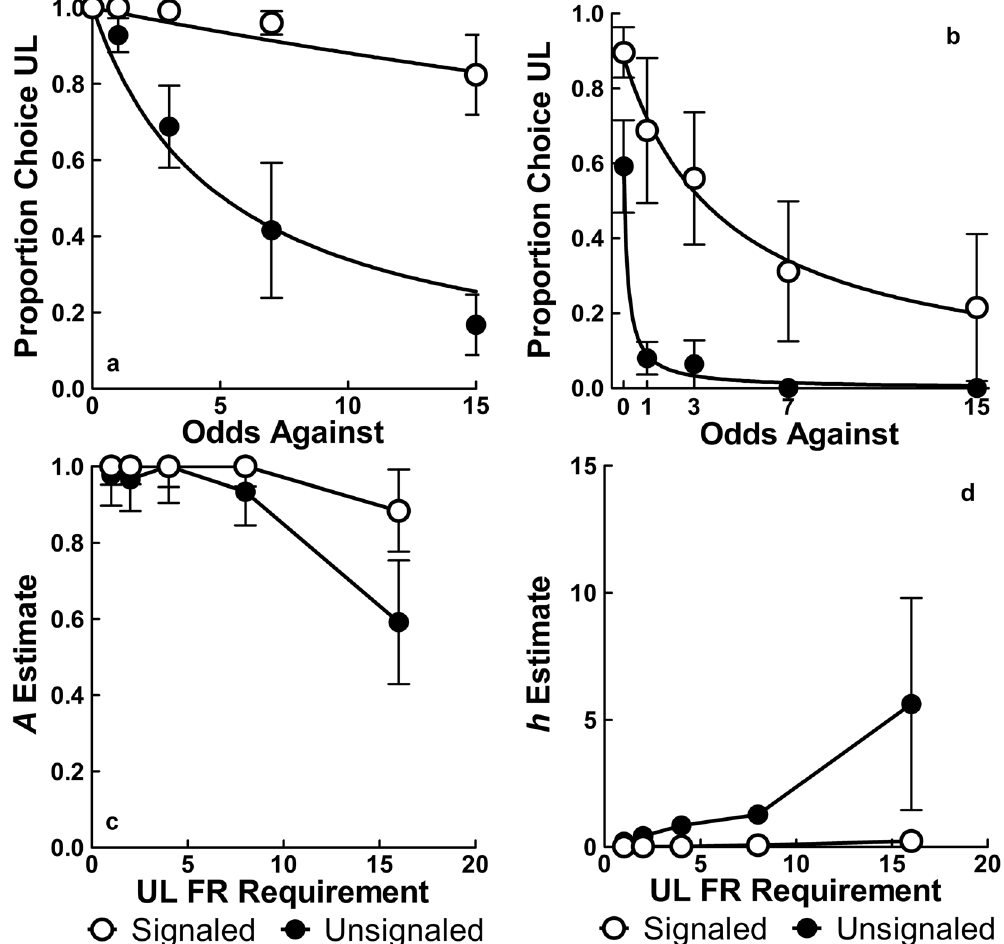
Figure 6. Top: mean ( ± SEM) proportion choice UL for the Signaled and Unsignaled groups at response costs of 1 ( a ) and 16 ( b ); additional costs can be seen in Supplementary Fig. S2. Bottom: mean ( ± SEM) A estimates ( c ) and h estimates ( d ) for the proportion choice UL (using Equation 1) as a function of UL response requirement ( n =